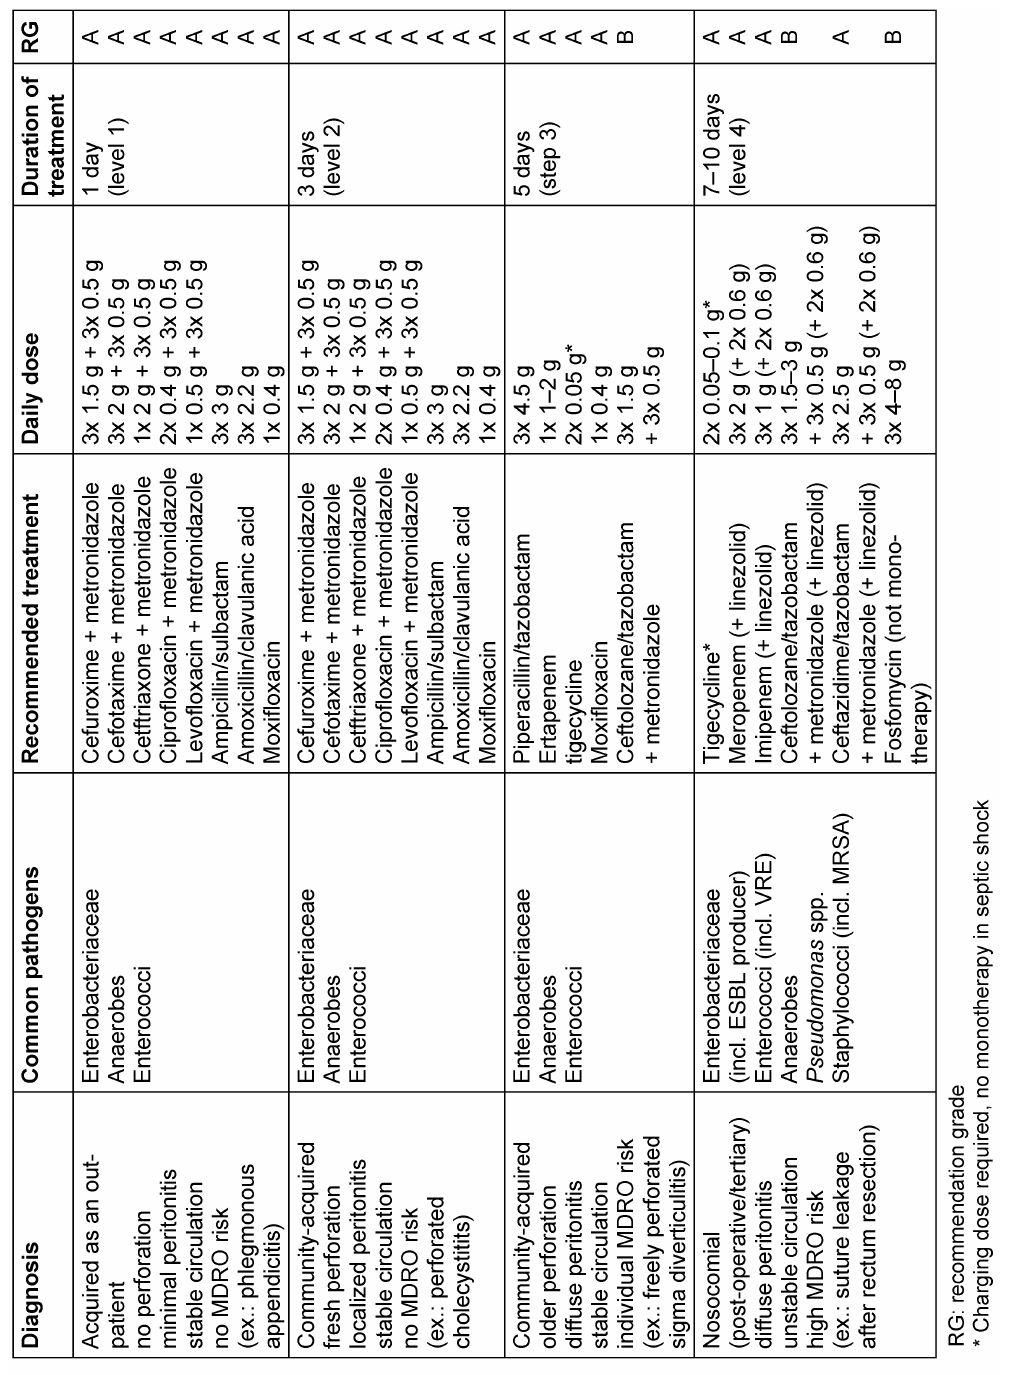
Table 4: Recommendations for the initial treatment of the different forms of secondary and tertiary